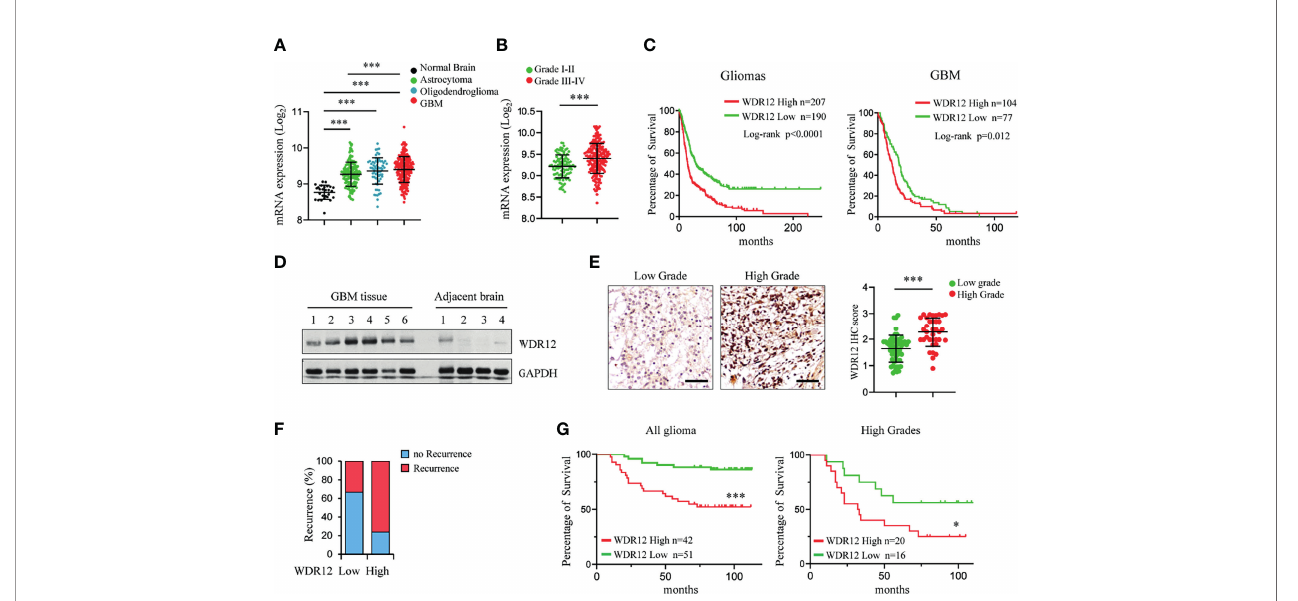
FIGURE 5 | Expression level of WDR12 is associated with poor survival in glioma and GBM. (A) Plots of WDR12 expression in normal brains, astrocytoma, oligodendroglioma and GBM from REMBRANDT glioma database. (B) Plots of WDR12 expression in grades I-II and grades III-IV gliomas from REMBRANDT glioma database. (C) Kaplan-Meier survival analysis of glioma and GBM patients from REMBRANDT glioma database strati fi ed by WDR12 expression. (D) IB showing the levels of WDR12 in human primary GBM tissues and adjacent normal brain tissues. (E – G) IHC analysis of WDR12 in a glioma tissue microarray. Representative images and plots of histoscore of WDR12 in low grades and high grades gliomas are shown (E) . Scale bars, 50 m m. (Low grades, n=57; High grades, n=36). The percentages of recurrence of gliomas in tumors with low (n=51) or high (n=42) expression of WDR12 are shown (F) . Kaplan-Meier survival analysis of patients with WDR12 low and WDR12 high expression in all gliomas (left) and high grade gliomas (right) are shown (G) . (Log rank test). Data are represented as mean ± SD. ***p < 0.001, as assayed by Unpaired Student ’ s t-test or Welch ’ s t test. *p < 0.05, ***p <